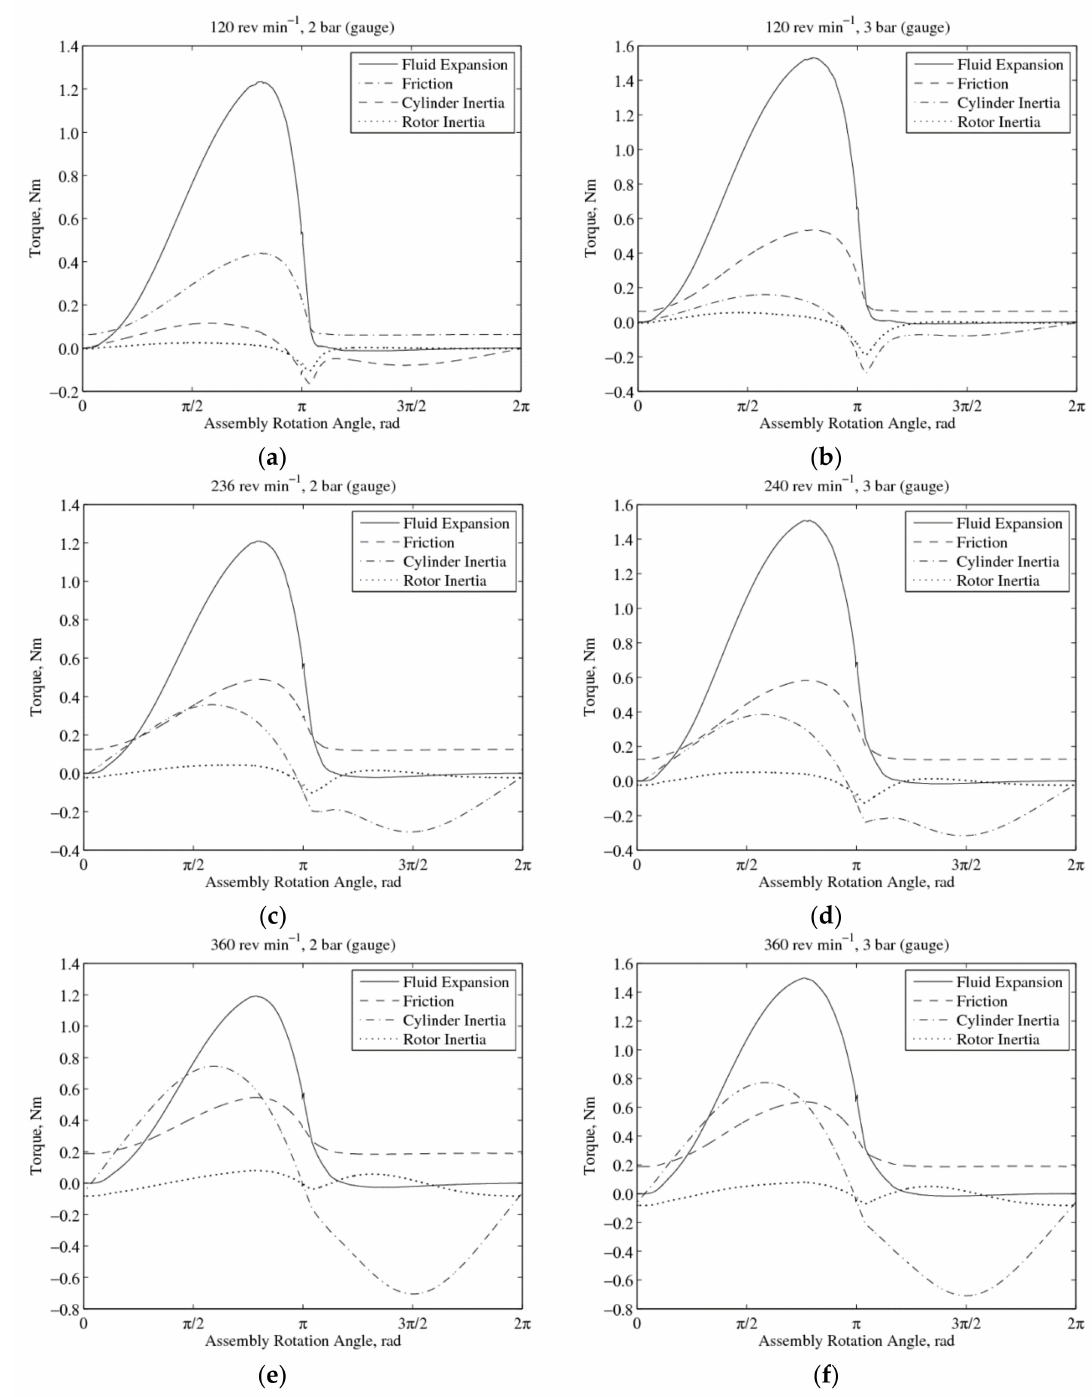
Figure 7. Torque components: ( a ) 120 rev min − 1 with 2 bar (gauge) inlet pressure; ( b ) 120 rev min − 1 with 3 bar (gauge) inlet pressure; ( c ) 236 rev min − 1 with 2 bar (gauge) inlet pressure; ( d ) 240 rev min − 1 with 3 bar (gauge) inlet pressure; ( e ) 360 rev min − 1 with 2 bar (gauge) inlet pressure; ( f ) 360 rev min − 1 with 3 bar (gauge) inlet